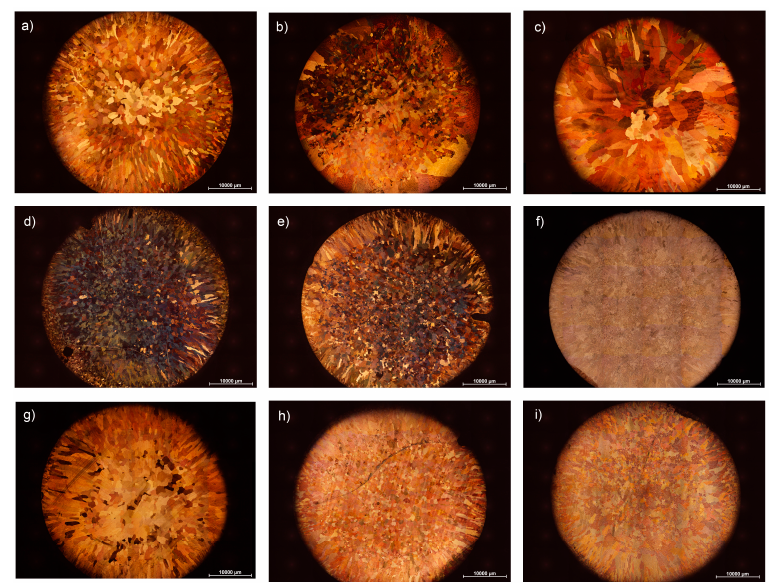
Figure 5. Macrographs of TP-1 samples, sectioned at a height of 38 mm. ( a ) 0.002 wt % Mg, ( b ) 0.023 wt % Mg, ( c ) 0.346 wt % Mg, ( d ) 0.051 wt % S, ( e ) 0.092 wt % S, ( f ) 0.373 wt % S, ( g ) 0.012 wt % P, ( h ) 0.087 wt % P, and ( i ) 0.501 wt % P. Macrographs ( h ) and ( i ) are reprinted with permission from [32], Taylor and Francis Ltd., 2017.